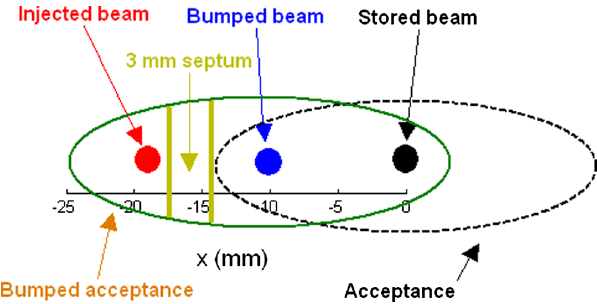
FIG. 22. Schematic layout of the separations between the stored, bumped and injected beams.